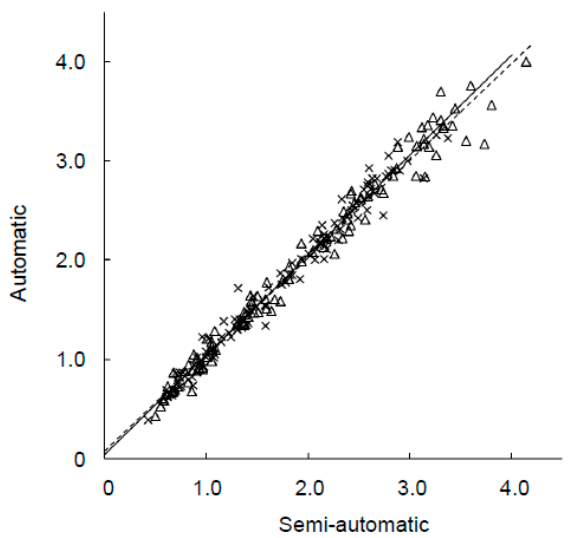
Figure 3. Scatter plot of SBR values from the semi- and fully automatic methods showed good linear correlations in both ACSC ( Δ : y = 0.98 x + 0.07, dashed line) and CTAC (×: y = 1.00 x + 0.04, solid line) image data ( r = 0.99).